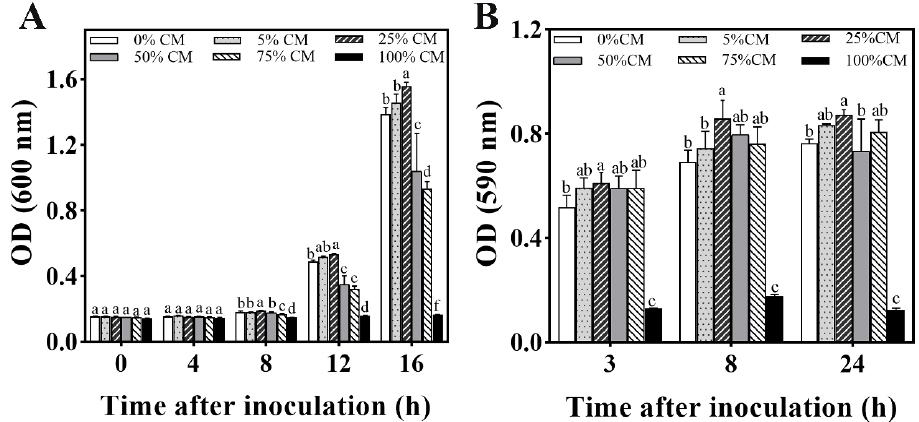
Figure 5. Effect of various concentrations of CM on ( A ) cell growth and ( B ) biofilm formation. Error bars indicate the standard deviation, and different letters indicate significant differences ( p < 0.05).